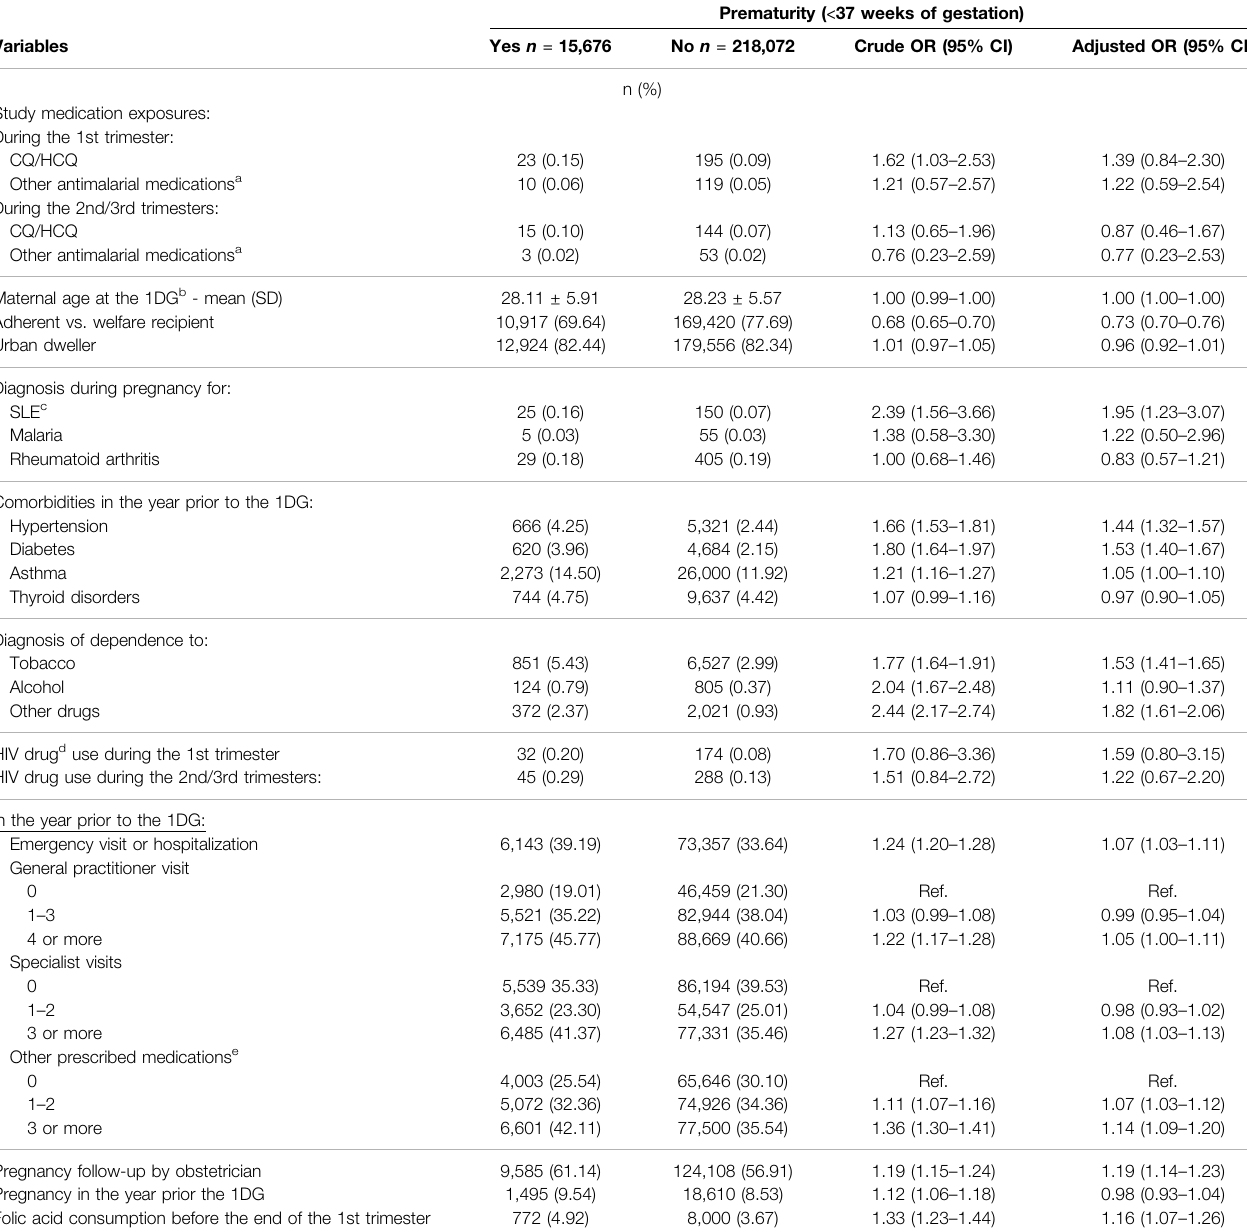
TABLE 2 | Association between CQ/HCQ exposure during pregnancy and the risk of